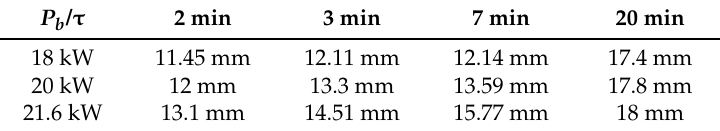
Table 6. Values of the height of the liquid pool in Ta at different P b and τ .